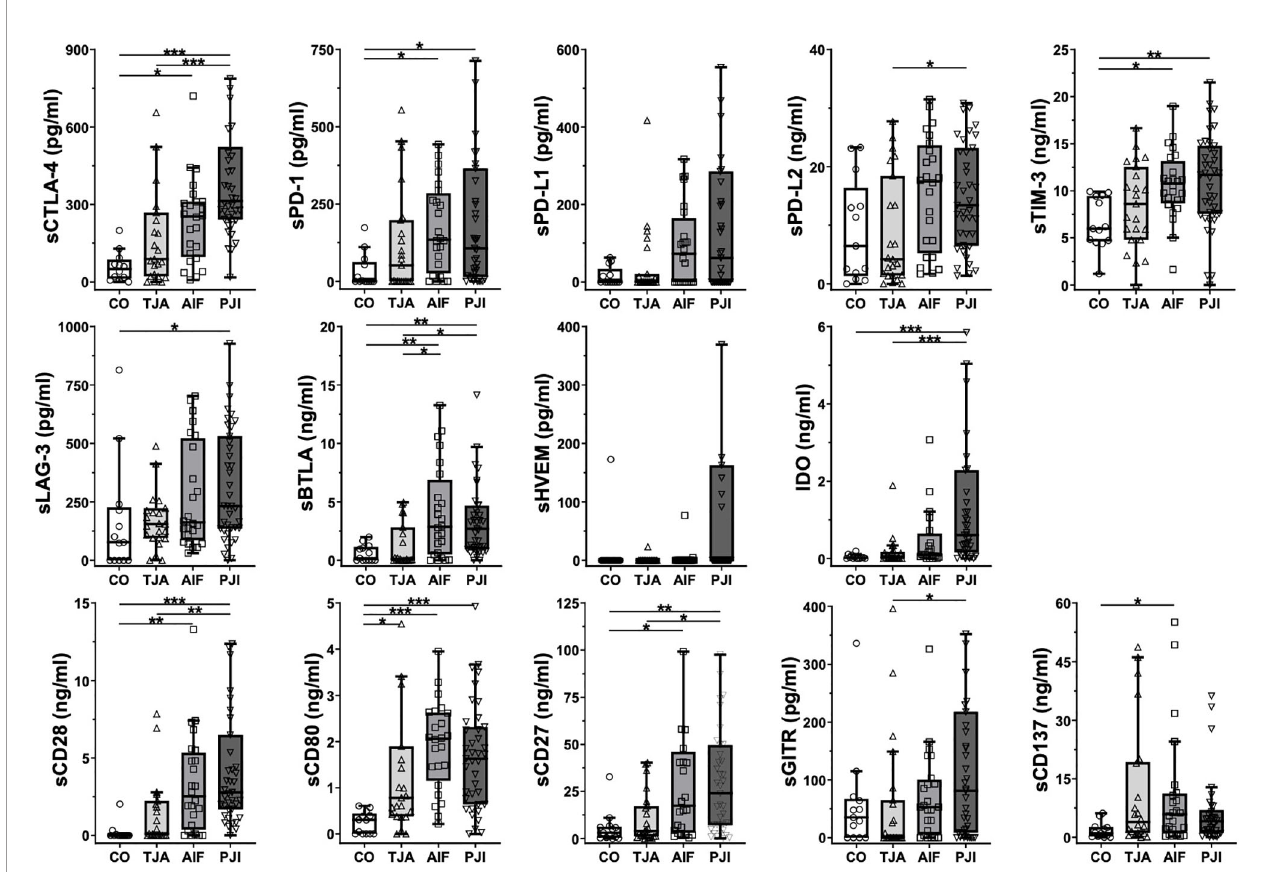
FIGURE 1 | Boxplots of the analyzed immunoregulatory markers. Boxplots show the median and interquartile range for each marker. Concentrations are given in pg/ml or ng/ml. In general, the control (CO) patients tended to have the lowest concentrations, whereas the highest concentrations were measured in AIF (sPD-1, sPD-L1, sPD-L2, sBTLA, sCD80, and sCD137) or PJI (sCTLA-4, sTIM-3, sLAG-3, sHVEM, IDO, sCD28, sCD27, and sGITR) patients. CO, control group; TJA, total joint arthroplasty; AIF, aseptic implant failure; PJI, periprosthetic joint infection; s, soluble; CTLA-4, cytotoxic T-lymphocyte-associated protein 4; PD-1, programmed cell death protein 1; PD-L1, programmed cell death 1 ligand 1; PD-L2, programmed cell death 1 ligand 2; TIM-3, T-cell immunoglobulin and mucin-domain containing-3; LAG-3, lymphocyte-activation gene 3; BTLA, B- and T-lymphocyte attenuator; HVEM, herpesvirus entry mediator; IDO, indolamin-2,3-dioxygenase; GITR, glucocorticoid-induced TNFR-related protein; CD, cluster of differentiation. *p < 0.05, **p < 0.01, ***p <